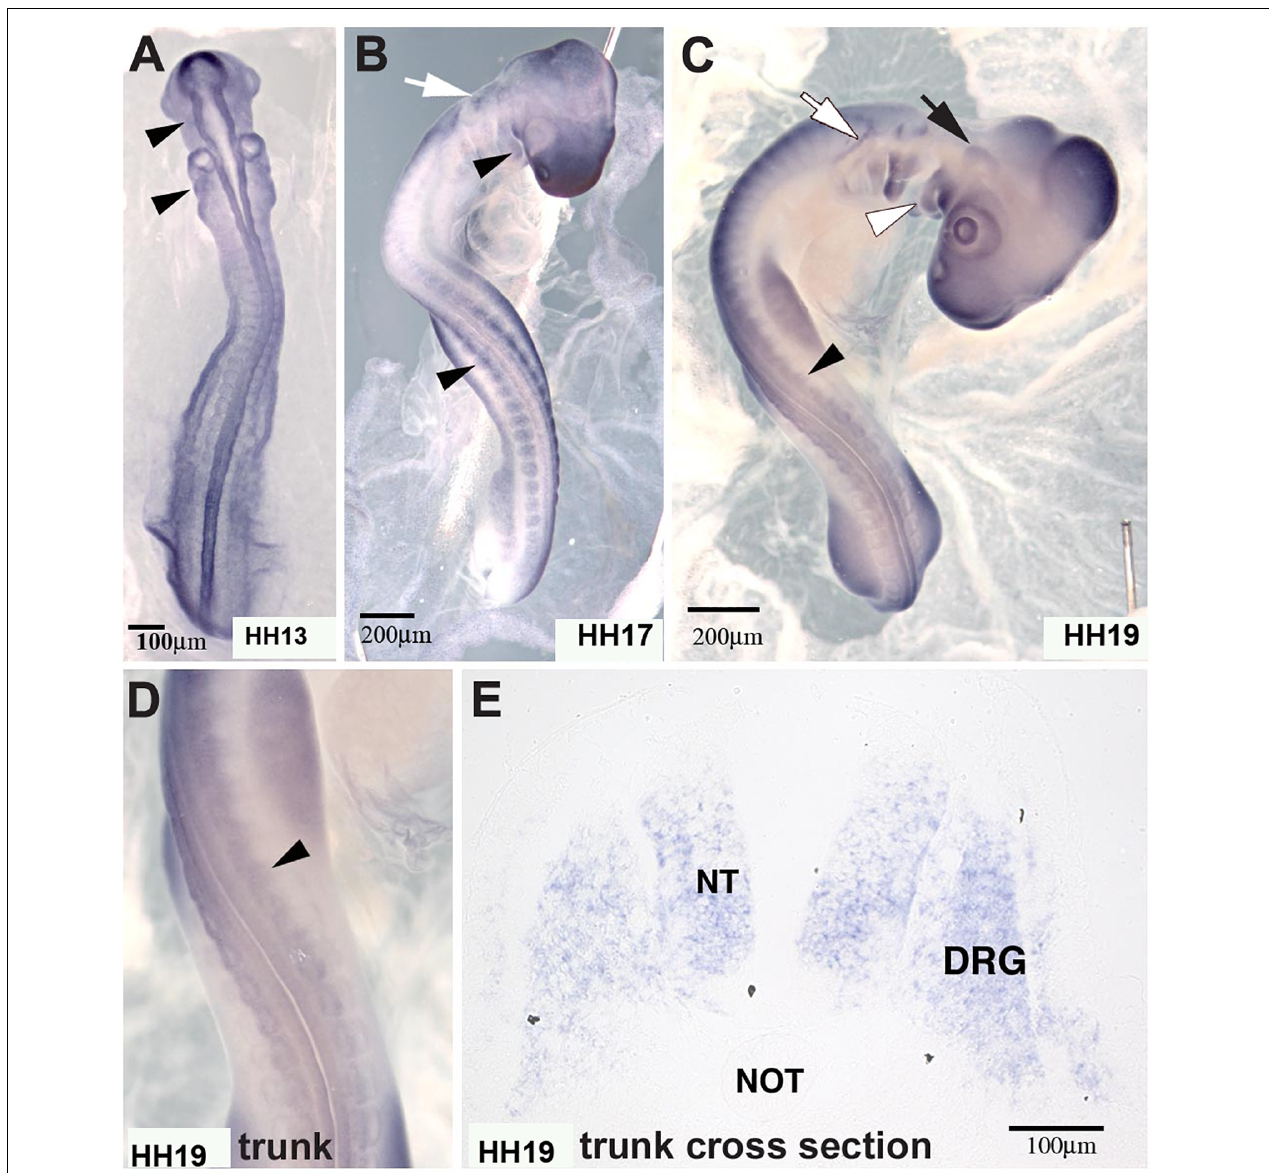
FIGURE 8 | Macrophage migration inhibitory factor (MIF) was expressed by NCC. (A) MIF was expressed in migrating cranial NCC (arrowheads) at HH13 (St.13, E2, 16–20 somites). (B) By HH17 (St.17, E2.5, 29–31 somites), MIF transcript could be detected in branchial arches (white arrowhead), tNCC (black arrowhead) in addition to cranial NCC (white arrow). (C) At HH19 (St.19, E3, 37–40 somites), MIF was expressed in the trigeminal ganglion (black arrow), epibranchial ganglia (white arrow), branchial arches (white arrowhead) and DRG (black arrowhead). (D) Higher magnification of the trunk region in (C) showed MIF expression in the developing DRG (black arrowhead). (E) Section in situ hybridization performed with HH19 trunk transverse section demonstrated that MIF could be observed in the neural tube (NT) and dorsal root ganglia (DRG). Scale Bars are for